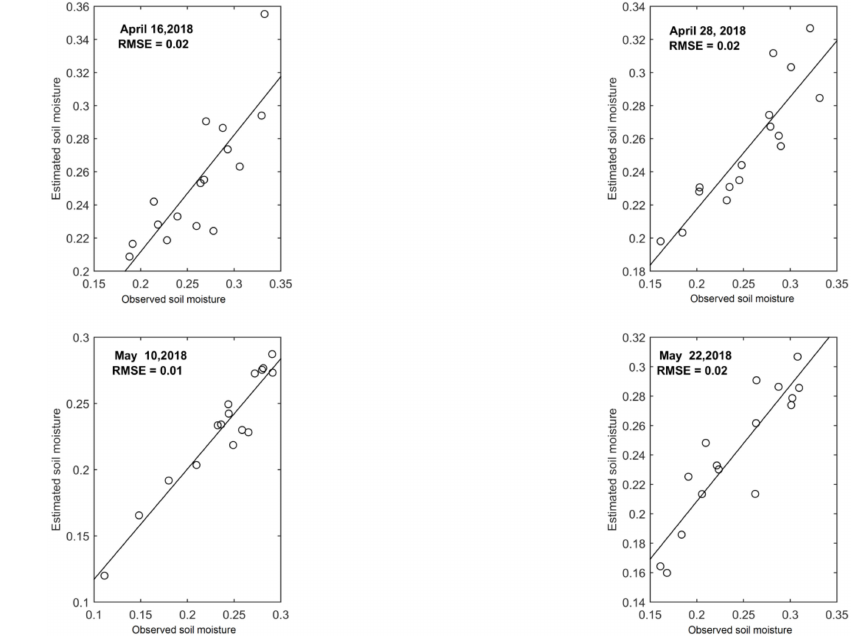
Figure 6. Localized models. Validation (2017 and 2018).